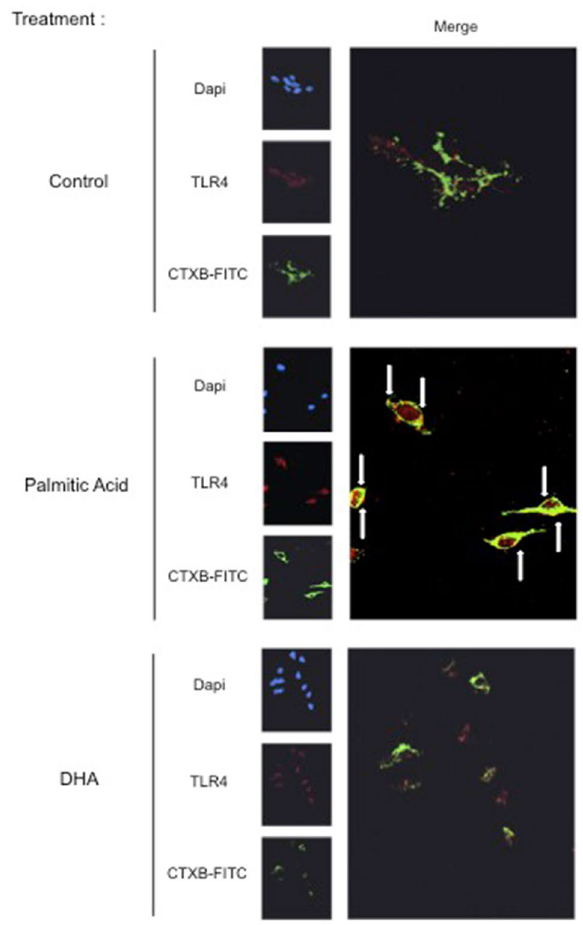
Figure 5. Palmitic acid induced TLR4 recruitment to membrane lipid rafts. Human SH-SY5Y cells were treated with palmitic acid, DHA or placebo during 4 h and fixed for immunohistochemistry analysis by confocal microscopy using antibodies directed towards CTXB (marker of membrane lipid rafts) or TLR4. The arrow in the merge indicated the co-localization of TLR4 and CTXB. Images were captured using a confocal microscope with high-magnification scan (X40). The figure is representative of two biological replicates and each image resulted from several slides that were analyzed by confocal